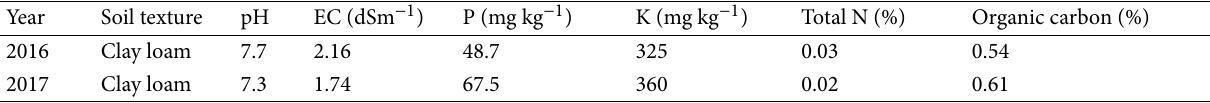
Table 2 Some physicochemical properties of the 0−30 cm soil depth of the study area. Year Soil